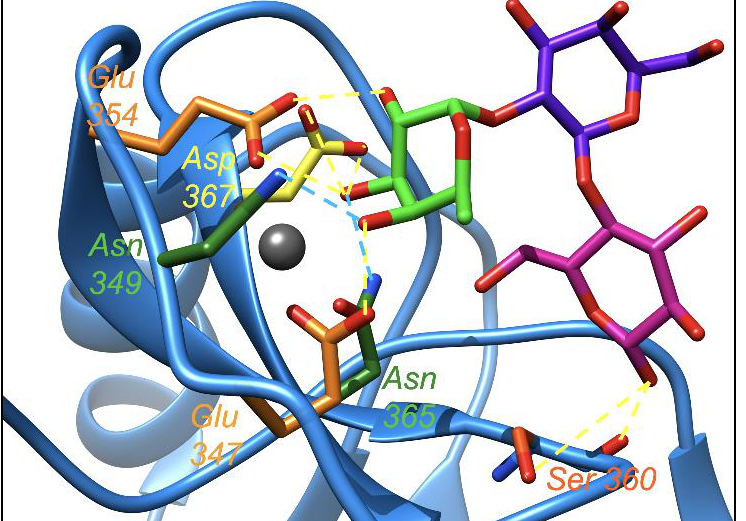
Figure 4. The hydrogen-bonding (dotted lines) network of 2 ꞌ -FL and DC-SIGN. DC-SIGN interacting domain is represented as a blue ribbon. Fucose is coloured in green; galactose is coloured in dark blue; glucose is coloured in magenta; Ca +2 is coloured as a grey sphere. All of the amino acids’ sidechain colours are matched with their respective label colours. The yellow dotted line represents interactions of 2 ꞌ -FL as a hydrogen bond donor. The blue dotted line represents the interactions of 2 ꞌ -FL as a hydrogen bond acceptor.